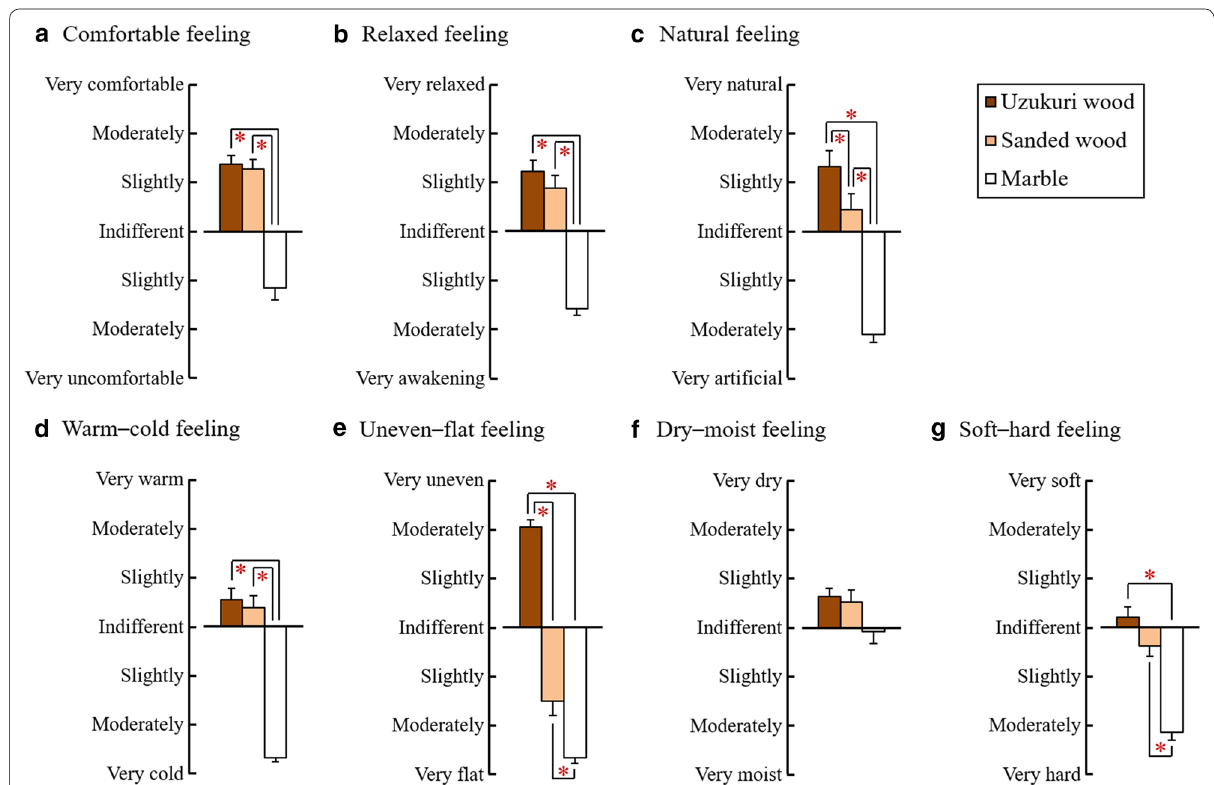
Fig. 7 Subjective evaluation using the modified semantic differential method after sole of the feet contact with the materials. a Comfortable feeling, b relaxed feeling, c natural feeling, d warm–cold feeling, e uneven–flat feeling, f dry–moist feeling, and g soft–hard feeling. n mean SE, * p < 0.05 as determined by using the Wilcoxon signed-rank test with Holm ±